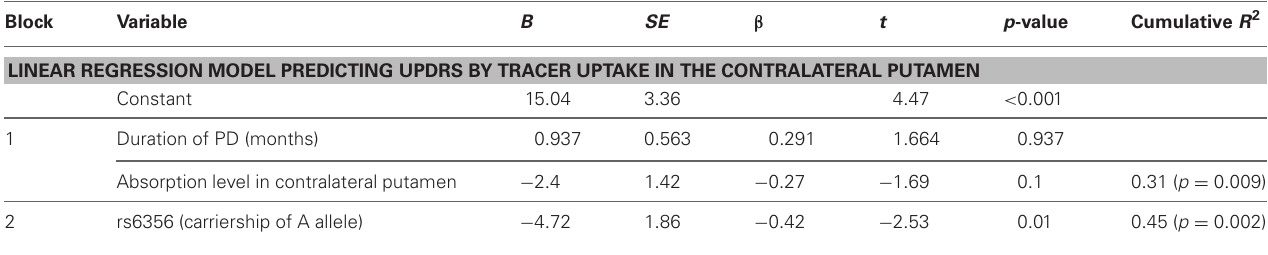
Table 2 | Summary of the linear regression model predicting UPDRS score by model; Block 2 was entered in a stepwise manner.